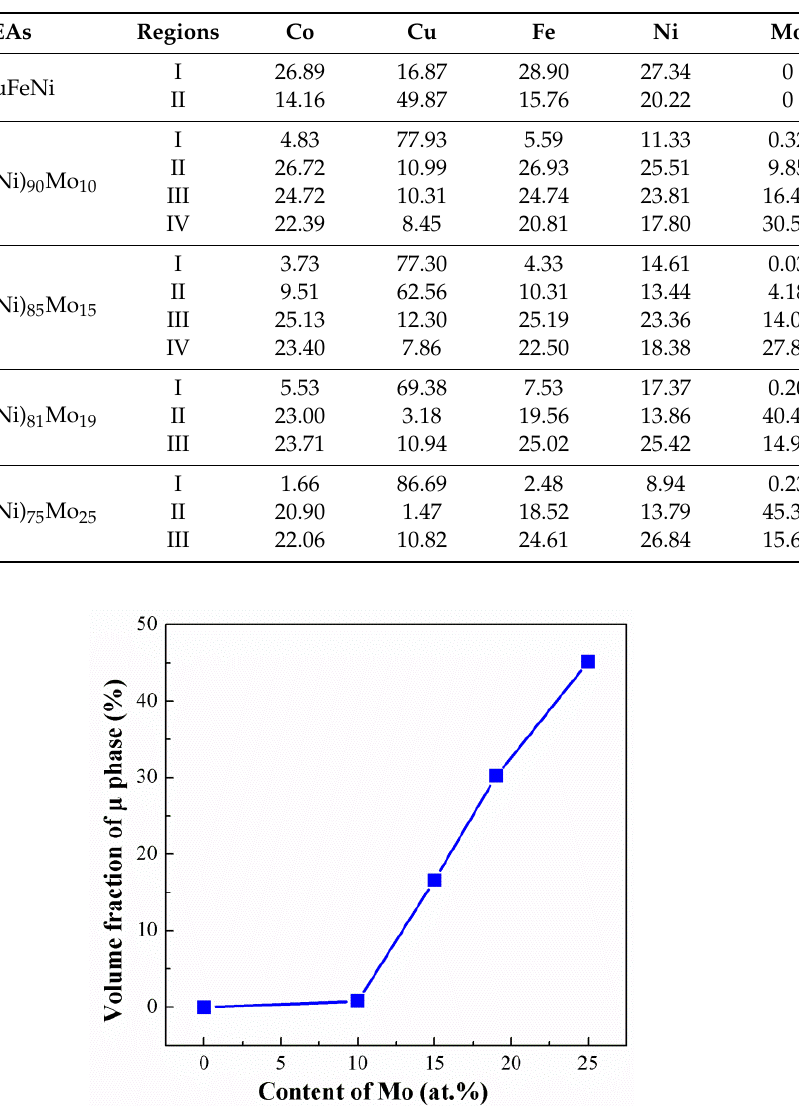
Figure 3. Volume fraction of the μ phase vs . the content of Mo in (CoCuFeNi) 100- x Mo x alloys. Detailed microstructure investigation for (CoCuFeNi) 81 Mo 19 HEA was performed by TEM. Bright-field (BF) images are shown in Figure 4. Additionally, Figure 4b presents a high-resolution transmission electron microscopy (HRTEM) image of the (CoCuFeNi) 81 Mo 19 alloy near the interface between the FCC phase and µ phase. The corresponding fast Fourier transform (FFT) images are shown in Figure 4c,d. The inverse fast Fourier transform (FFT) image, corresponding to the region of HRTEM (marked in Figure 4b by a red square) confirmed the emergence of a coherent interface between the two phases. The FCC phase and the µ phase were coherent with [110] FCC // [110] µ and {111} FCC // {113} µ . Several dislocations could be observed near the interface, which could be resulted from the lattice misfit between two di ff erent phases. Previous reports have suggested that the coherent interface can e ff ectively hinder dislocation motion and greatly enhance the mechanical properties of alloys